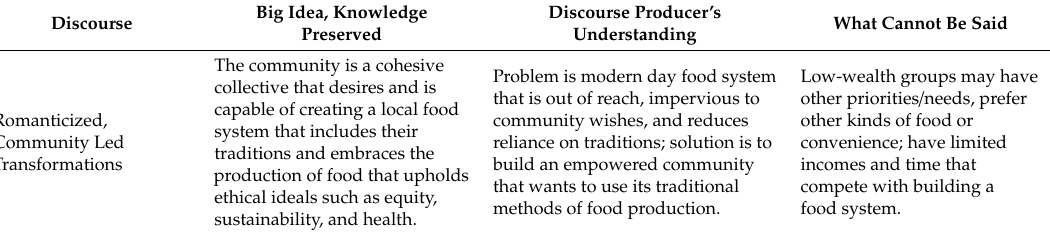
Table 3. Thick Descriptions of Discourses and Narrative